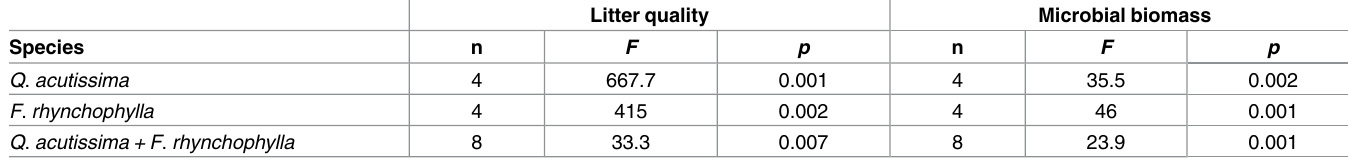
Table 3. Summaryof the MANOVA results for the effect of elevated CO 2 on Q . acutissima and F . rhynchophylla . Litter quality Microbial